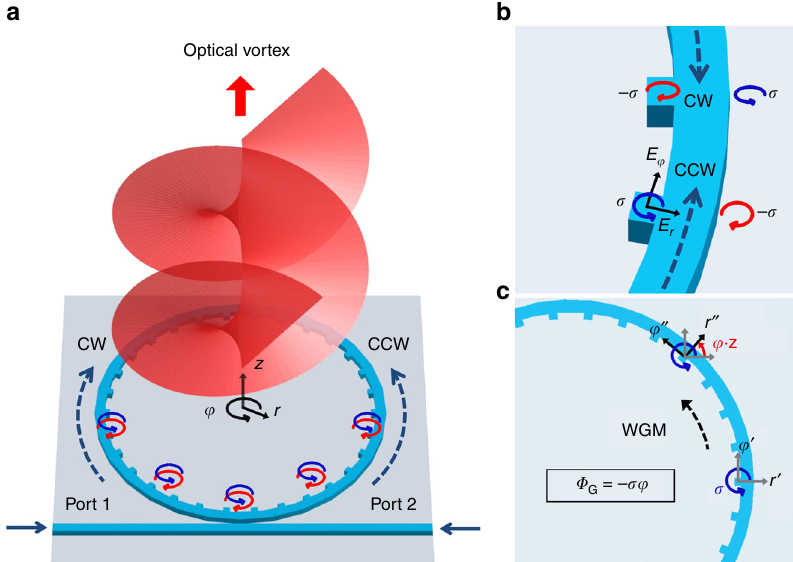
Fig. 1 Illustration of the concepts. a Schematic of the platform for the investigation of transverse spin-induced SOI effect. b The clockwise (CW) and counter-clockwise (CCW) WGMs present opposite transverse spins on each side of the resonator. c Illustration of the transverse-spin-dependent geometric phase acquired by the vector evanescent wave as the WGM travels around the resonator. For the CCW WGM shown here, a rotation angle of φ · z is experienced by the local coordinates from point ( r ′ , φ ′ ) to ( r ″ , φ ″ ), and the geometric phase imparted on the evanescent wave with a transverse-spin state σ is Φ G = −